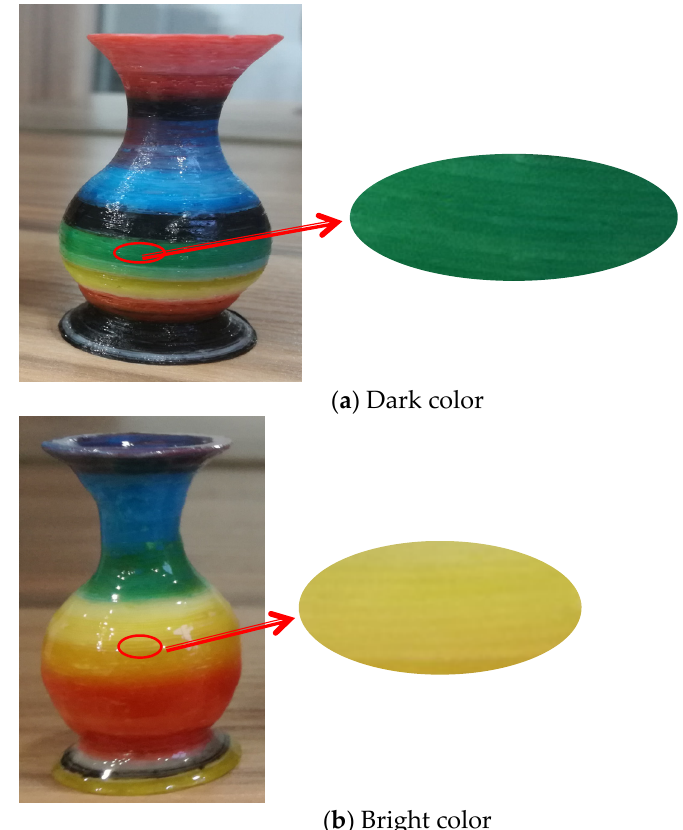
Figure 15. Printed colored objects (surface painting) for ( a ) dark color and ( b ) bright color .